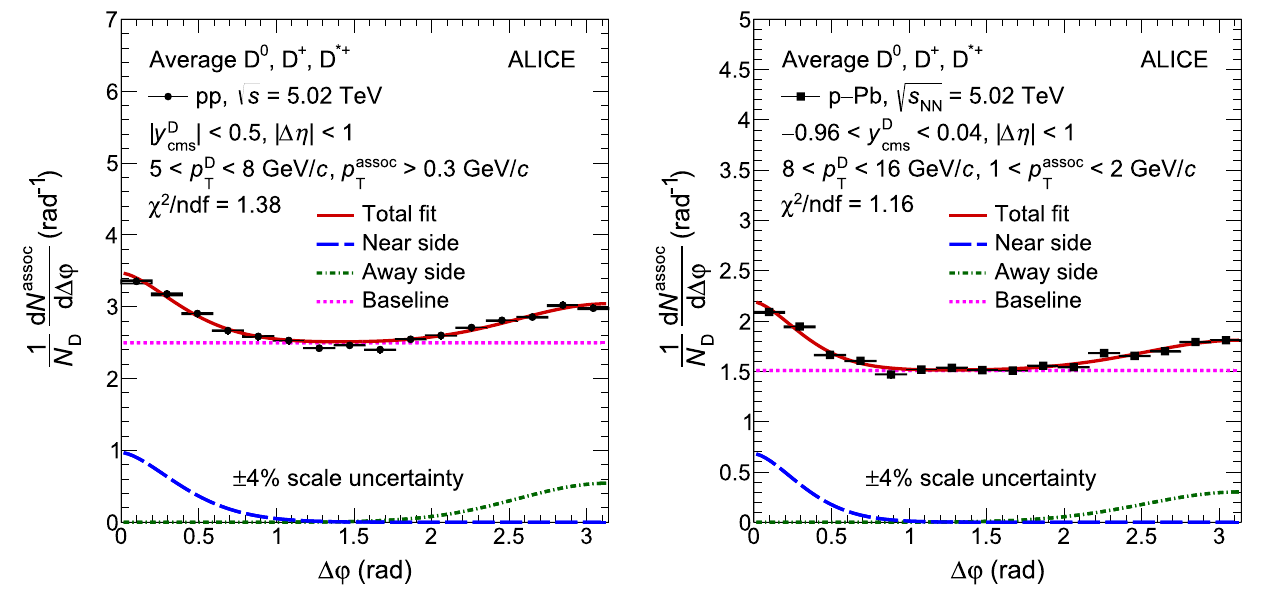
Fig. 2 Examples of the fit to the D-meson average azimuthal- solid curve. Its different terms are shown separately: near-side gener- < 8 GeV / c , p assoc > 0 . 3 GeV / c in pp correlation function, for 5 < p D alised Gaussian function, away-side Gaussian function, and baseline T T < 16 GeV / c , 1 < p assoc < 2 GeV / c constant term. The scale uncertainty (see Sect. 4) is also reported for collisions (left), and for 8 < p D T T in p–Pb collisions (right). The statistical uncertainties are shown as ver- tical error bars. The fit function described in Eq. 3 is shown as a red